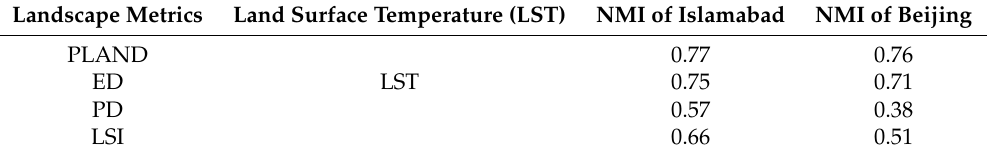
Table 9. Normalized mutual information (NMI) between LST and landscape metrics. Landscape